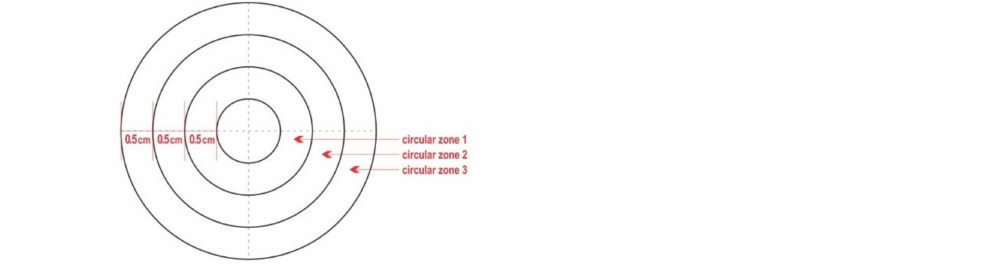
Figure 1. Diagram of the polar chart-type complex that was drawn on each piece of teatcup material. Before inoculation of staphylococci on the material (smearing), the pieces were thor- oughly cleaned with povidone-iodine (Betadine surgical scrub; Mundipharma AG, Basel, Switzerland), which after 10 min was rinsed with sterile phosphate-buffer-saline (PBS) pH 7.4 and fully dried with sterile